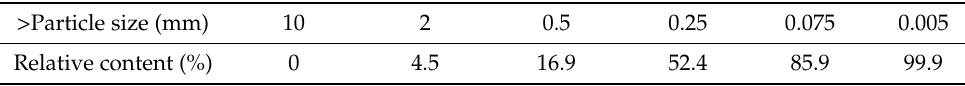
Table 2. The content of each particle size of